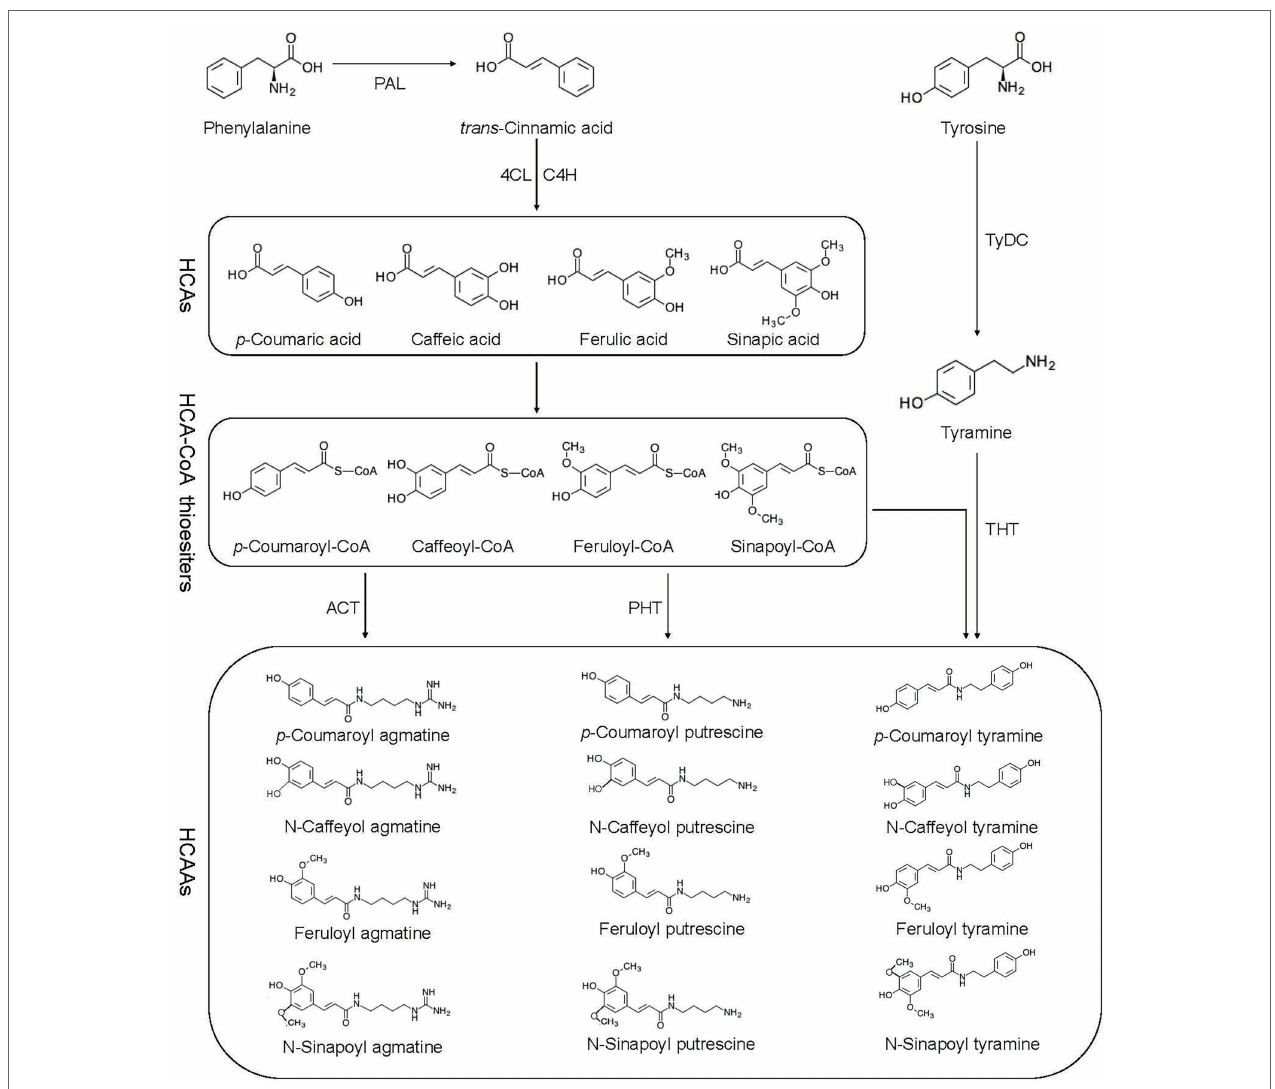
FIGURE 1 | Biosynthetic pathway of HCAAs. HCAAs, hydroxycinnamic acid amides; HCAs, hydroxycinnamic acids; PAL, phenyl alanine ammonia lyase; C4H, cinnamate 4-hydroxylase; 4-CL, 4-coumarate: CoA ligase; ACT, agmatine coumaryl transferase; TyDC, tyrosine decarboxylase; THT, tyramine hydroxycinnamoyl transferase; and PHT, putrescence hydroxycinnamoyl